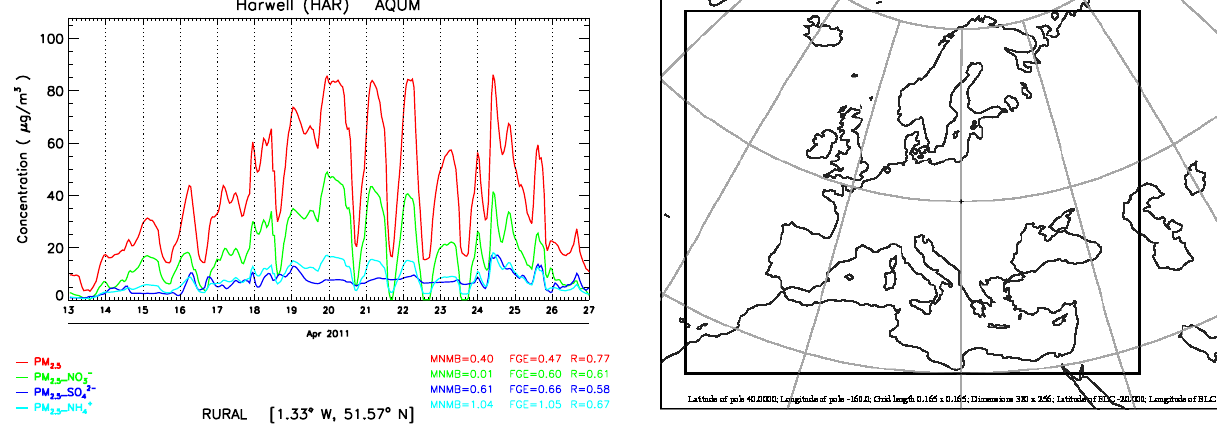
Fig. 15. Location of the intermediate European domain used to eval- uate sensitivity to LBCs.